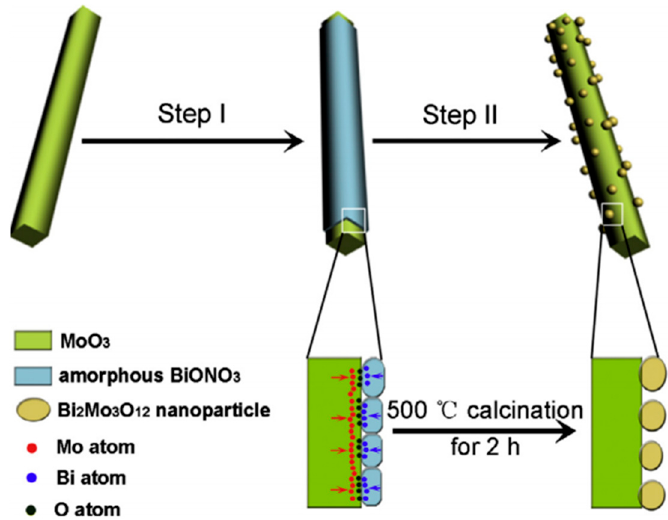
Figure 17. Step-by-step illustration of the fabrication of a Bi 2 Mo 3 O 12 /MoO 3 nano heterostructure photocatalyst by Liu et al. Reprinted from [166] with permission from Elsevier.